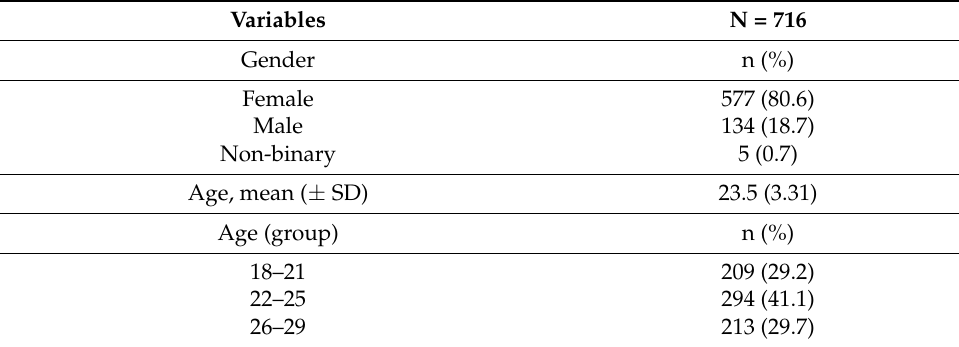
Table 1. Sociodemographic characteristics of